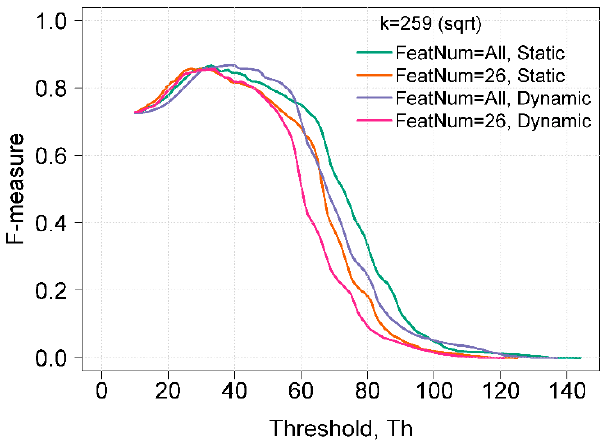
Figure 4. Comparison of F-measure results using different histogram construction methods and feature sets. Table 2. Comparison of F-measure results with related